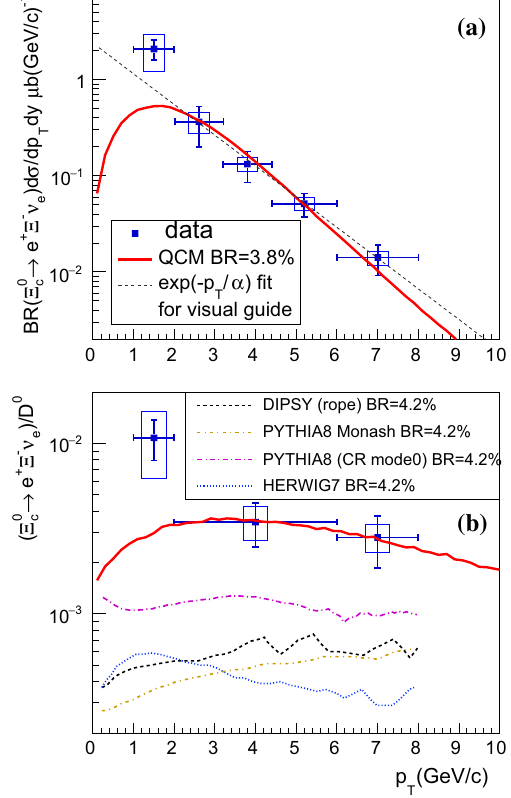
Fig. 5 Differential cross-section of Ξ 0 c at mid-rapidity multiplied by the branch ratio into e + Ξ − ν e ( a ) and the ratio to D 0 ( b ) as the function √ s = 7 TeV. Symbols are experimental data of p T in pp collisions at [51]andthethicksolidlinesareresultsofQCM.Resultsofothermodels or event generators in panel ( b ) are taken from